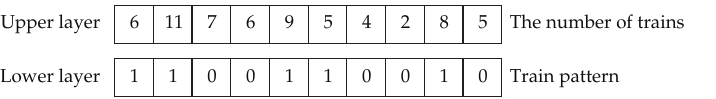
Figure 2: The illustration of a chromosome with two-layer coding approach.